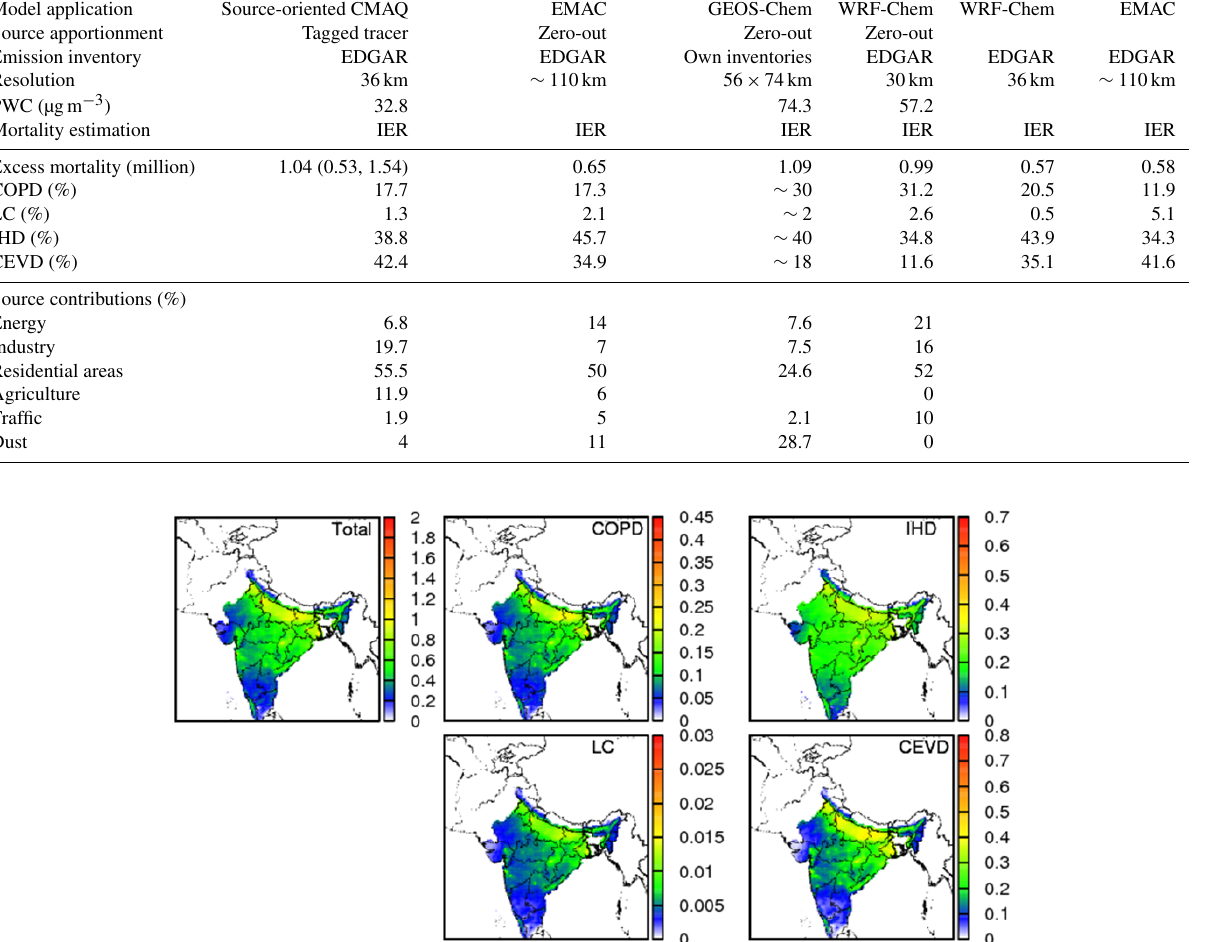
Table 2. Comparison of methods and excess mortality by diseases and sources from this study with other studies in India. Lelieveld (2017) and